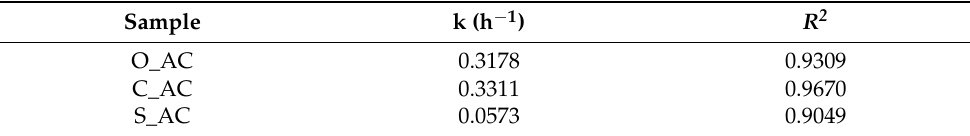
Table 6. The α -pinene isomerization kinetic parameters.